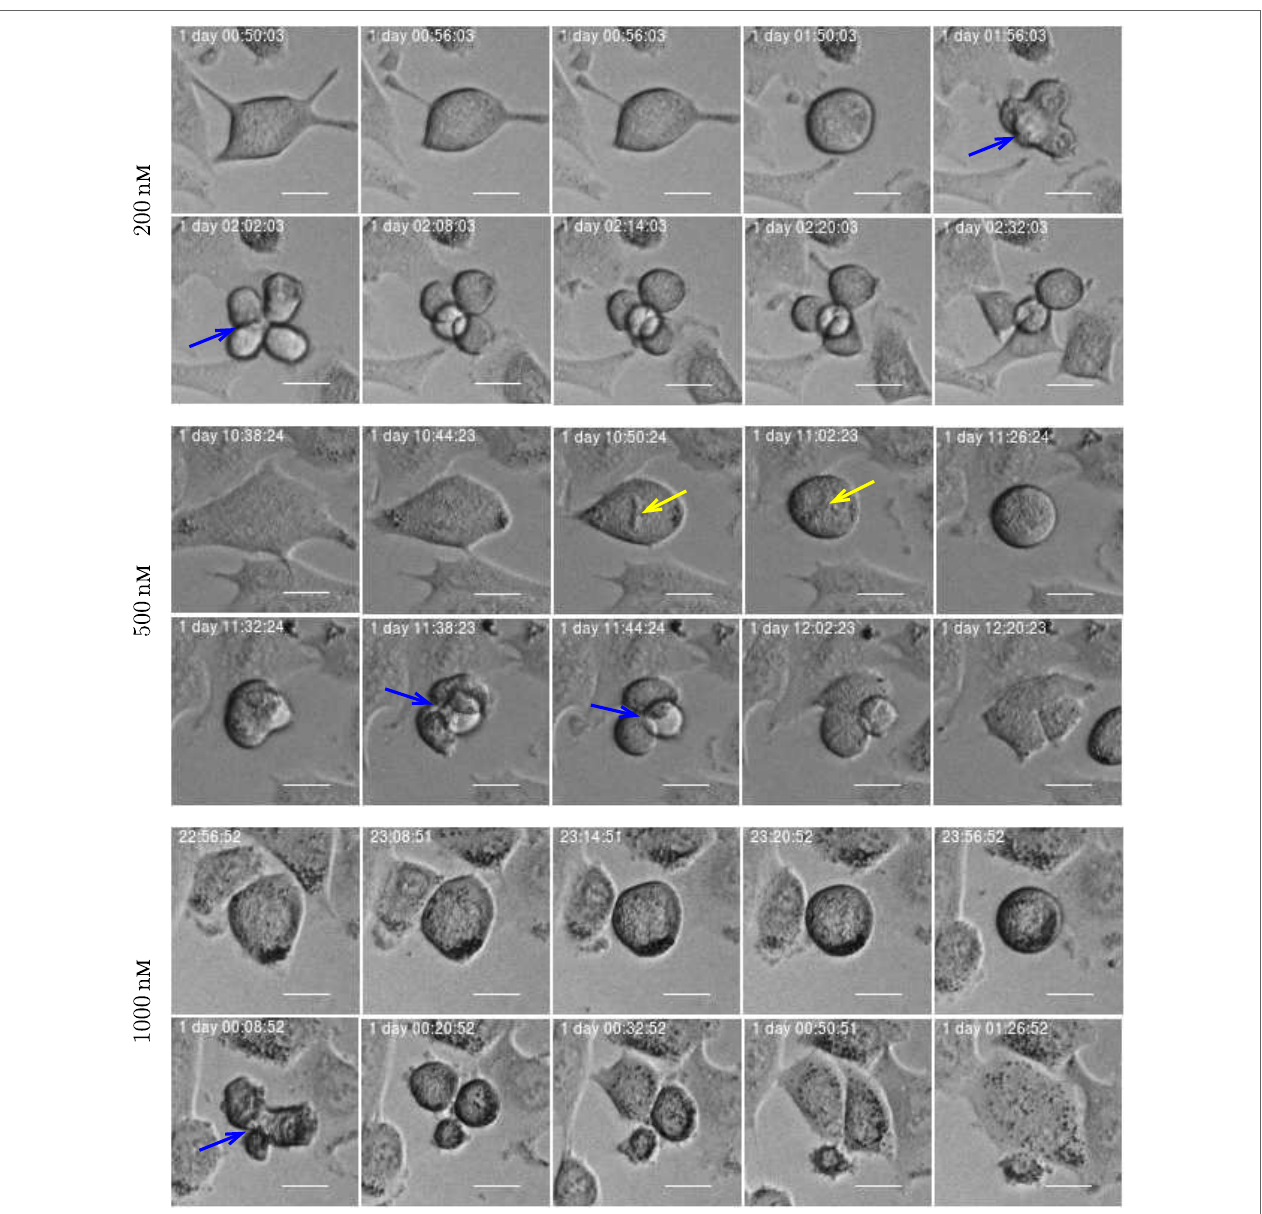
FigUre 16 | Three examples of asymmetric cell division for A549 cells exposed to YTX at concentrations 200, 500, and 1,000 nM (respectively from top to bottom). Blue arrow illustrates multipolar mitosis and yellow arrow shows a defective mitotic spindle morphology which may affect chromosome alignment. Scale bar: 20